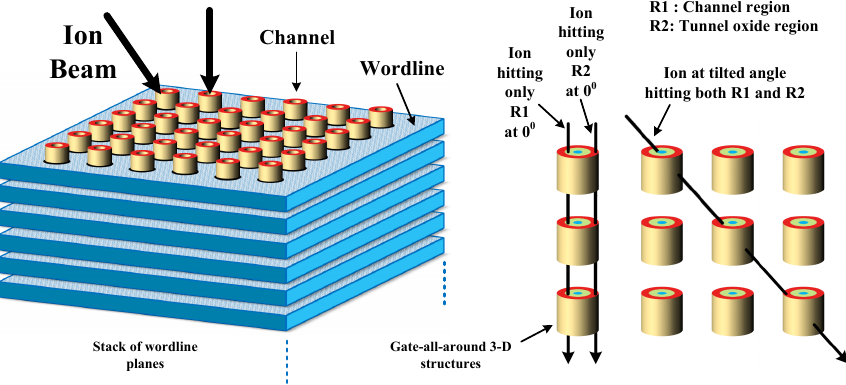
Figure 9. Mechanism of radiation strike on sensitive nodes of 3-D NAND